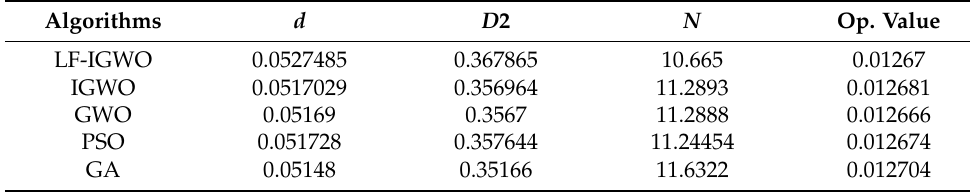
Table 10. Comparison of the data values of LF-IGWO with other techniques.